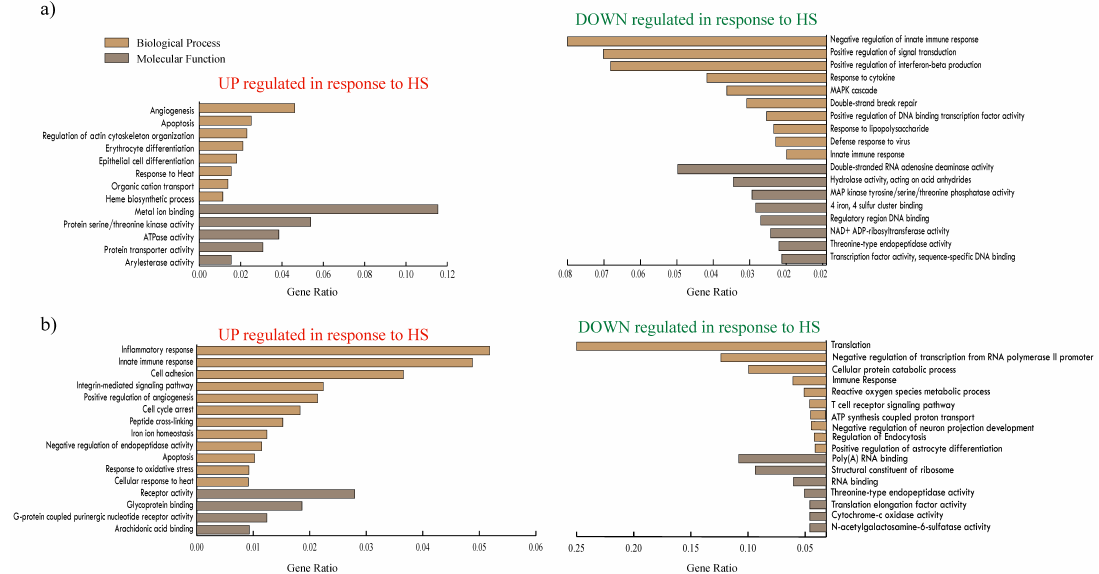
Figure 2. Gene Ontology analysis: ( a ) enriched GOs in female group; ( b ) enriched GOs in male